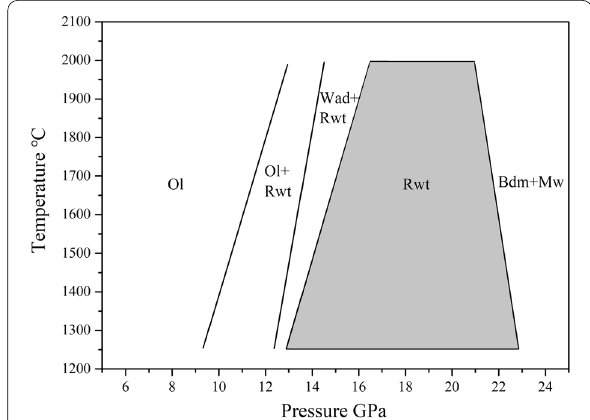
Fig. 9 Pressure–temperature phase diagram for olivine (Fo 65 ) after Ito and Takahashi (1989), Frost (2008), Tomioka and Miyahara (2017). The shaded region corresponds to the ringwoodite stability field. Bdm, bridgmanite; Mw, magnesiowüstite; others are the same as